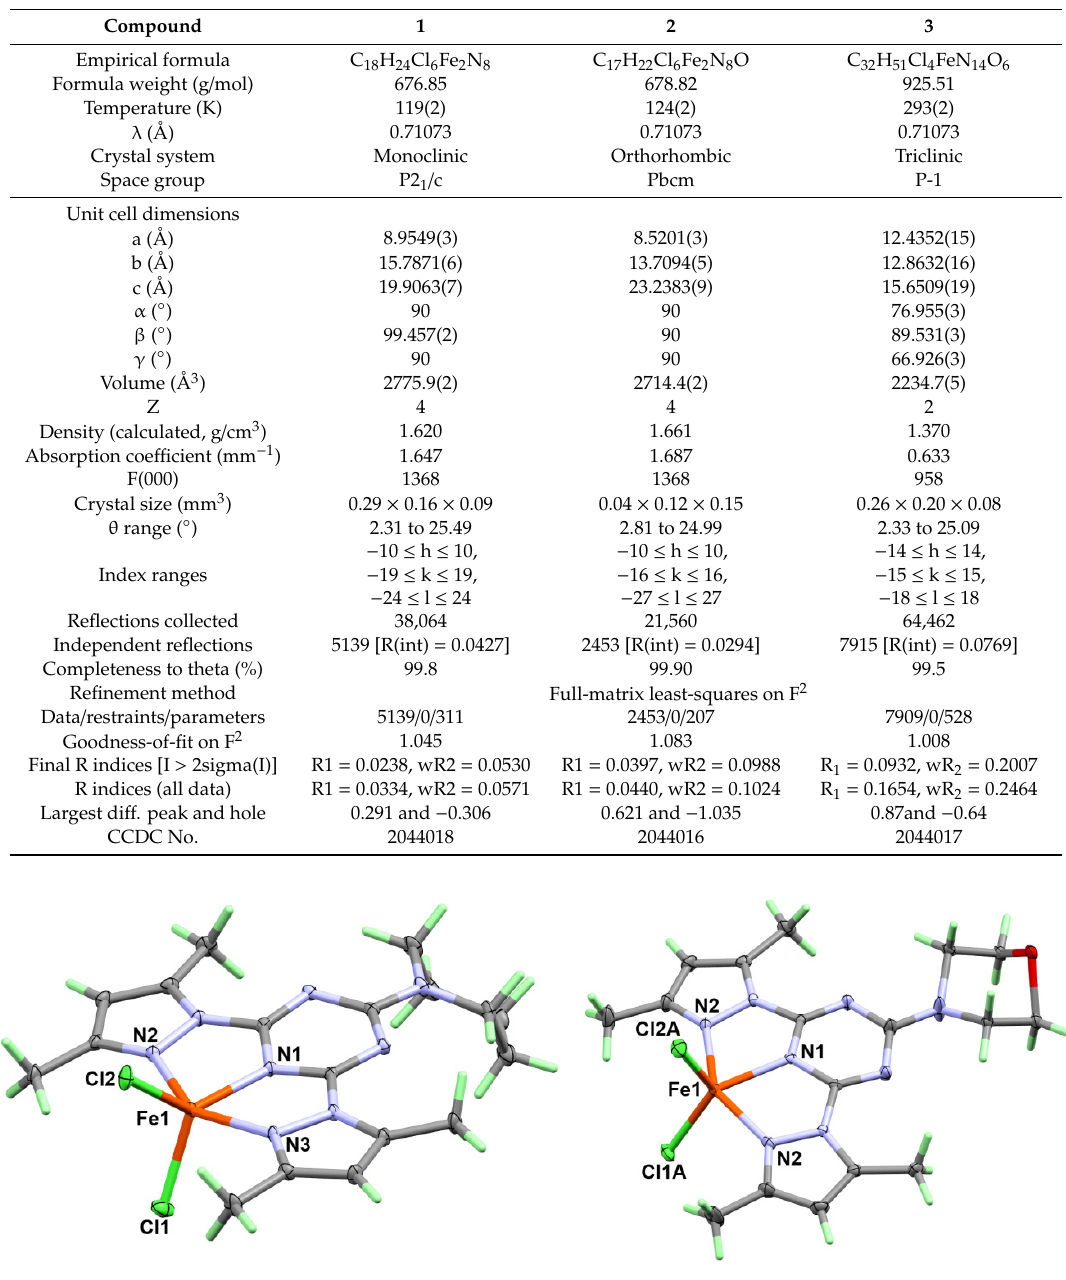
Table 1. Crystal data and structure refinement for the studied complexes.